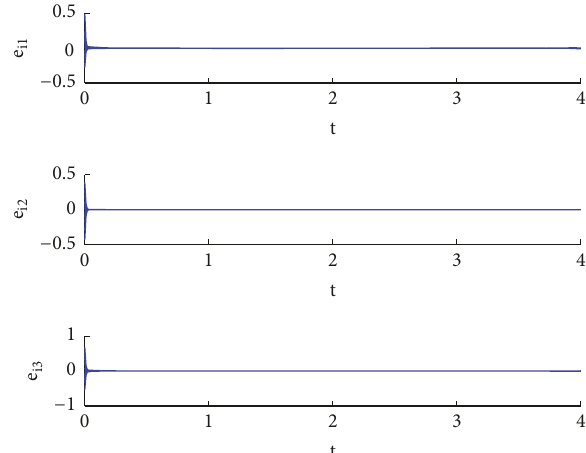
Figure 2: Finite-time mixed interlayer synchronization errors 𝑒 (𝑖 = 1,2,...,10) with 𝐴 ̸= 𝐵 . 𝑖